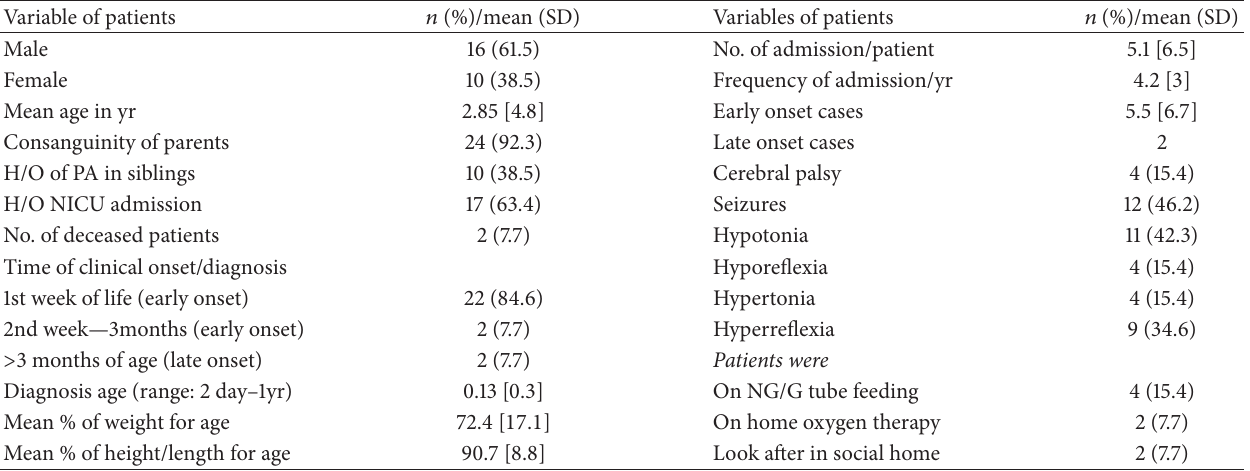
Table 1: Data of 26 patients with